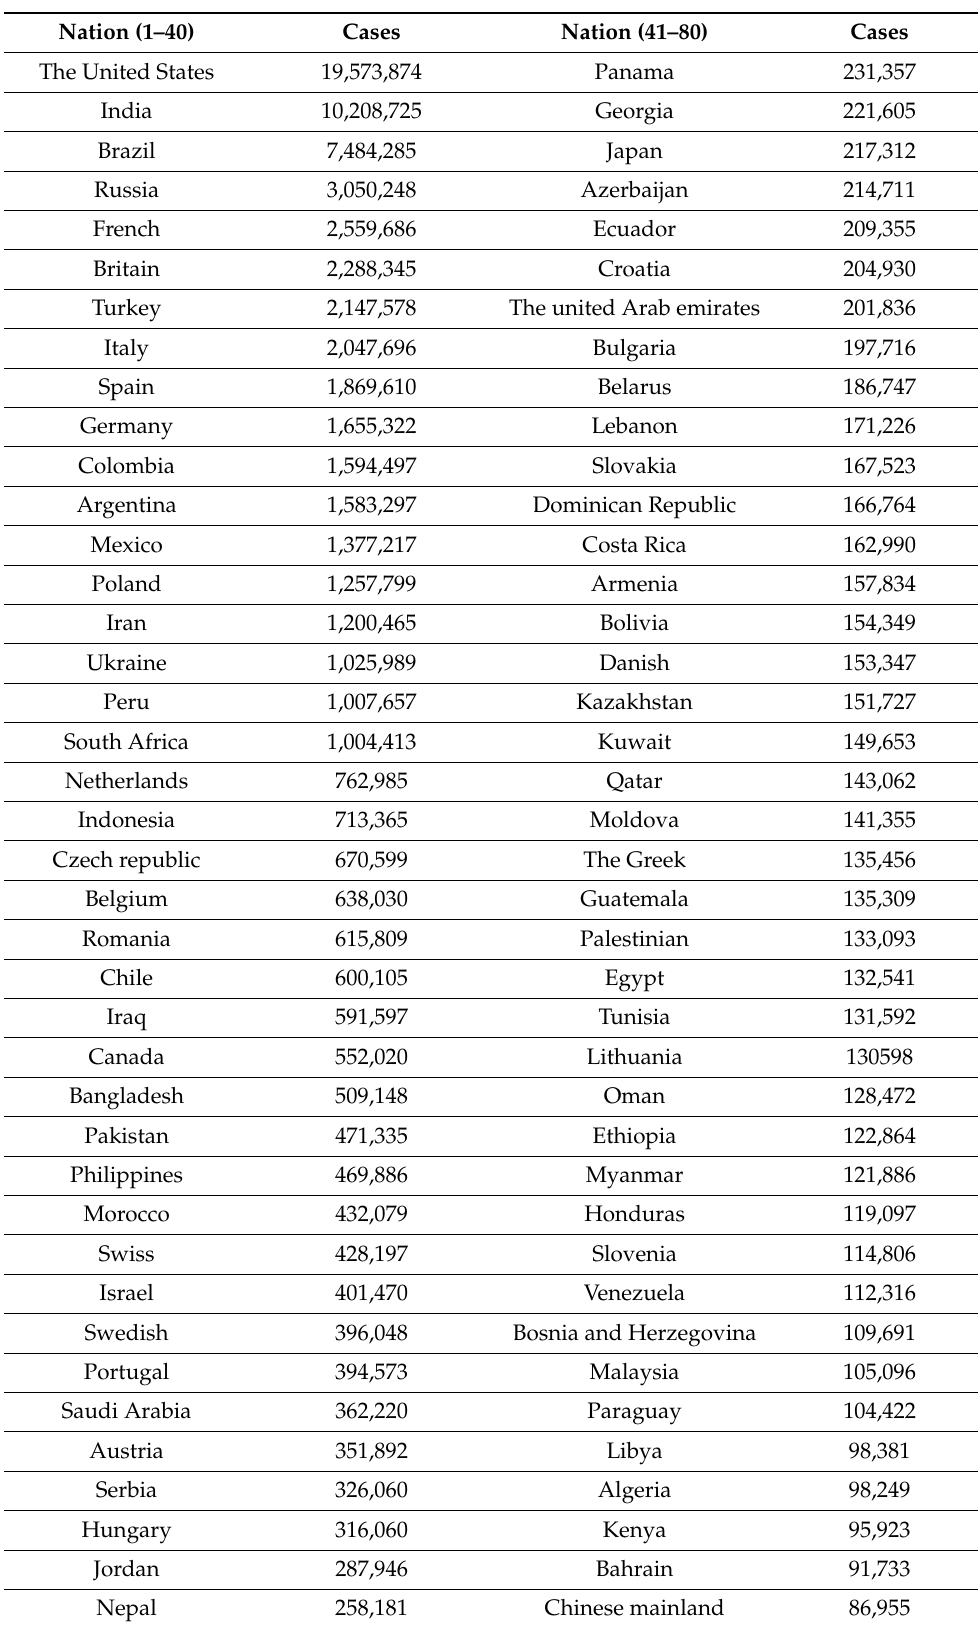
Table 1. Summary of COVID-19 cases by countries (those with >10,000